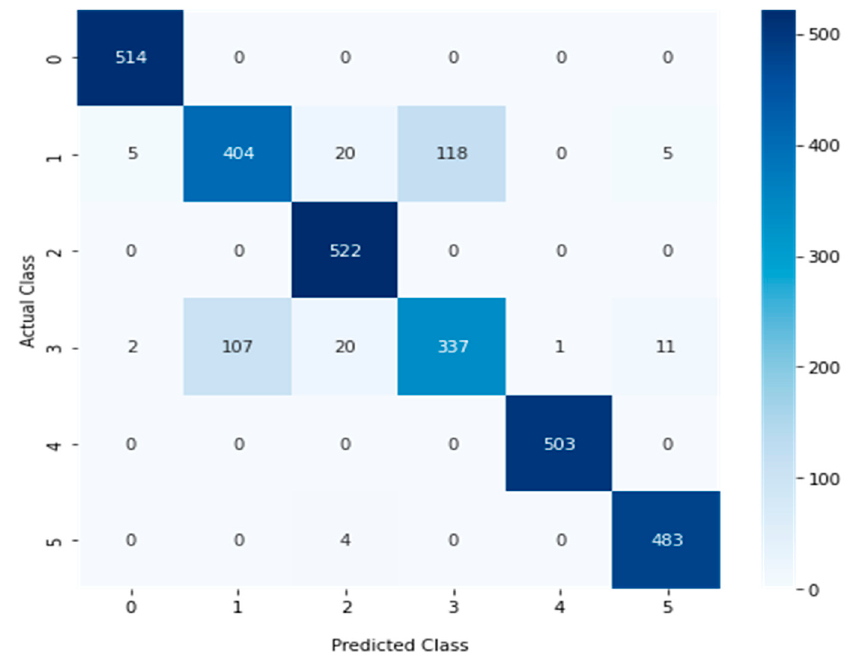
Figure 19. Confusion matrix of random forest.